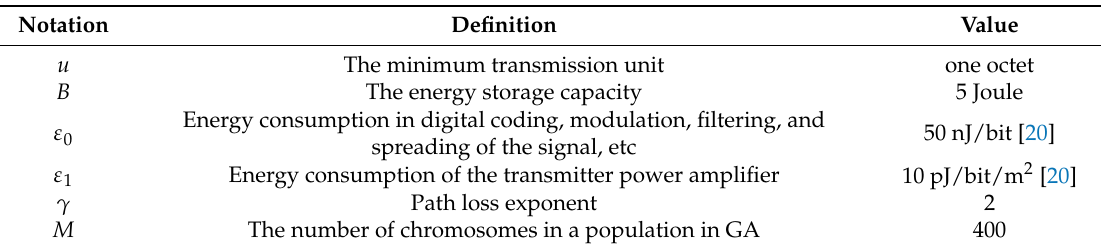
Table 2. Parameter